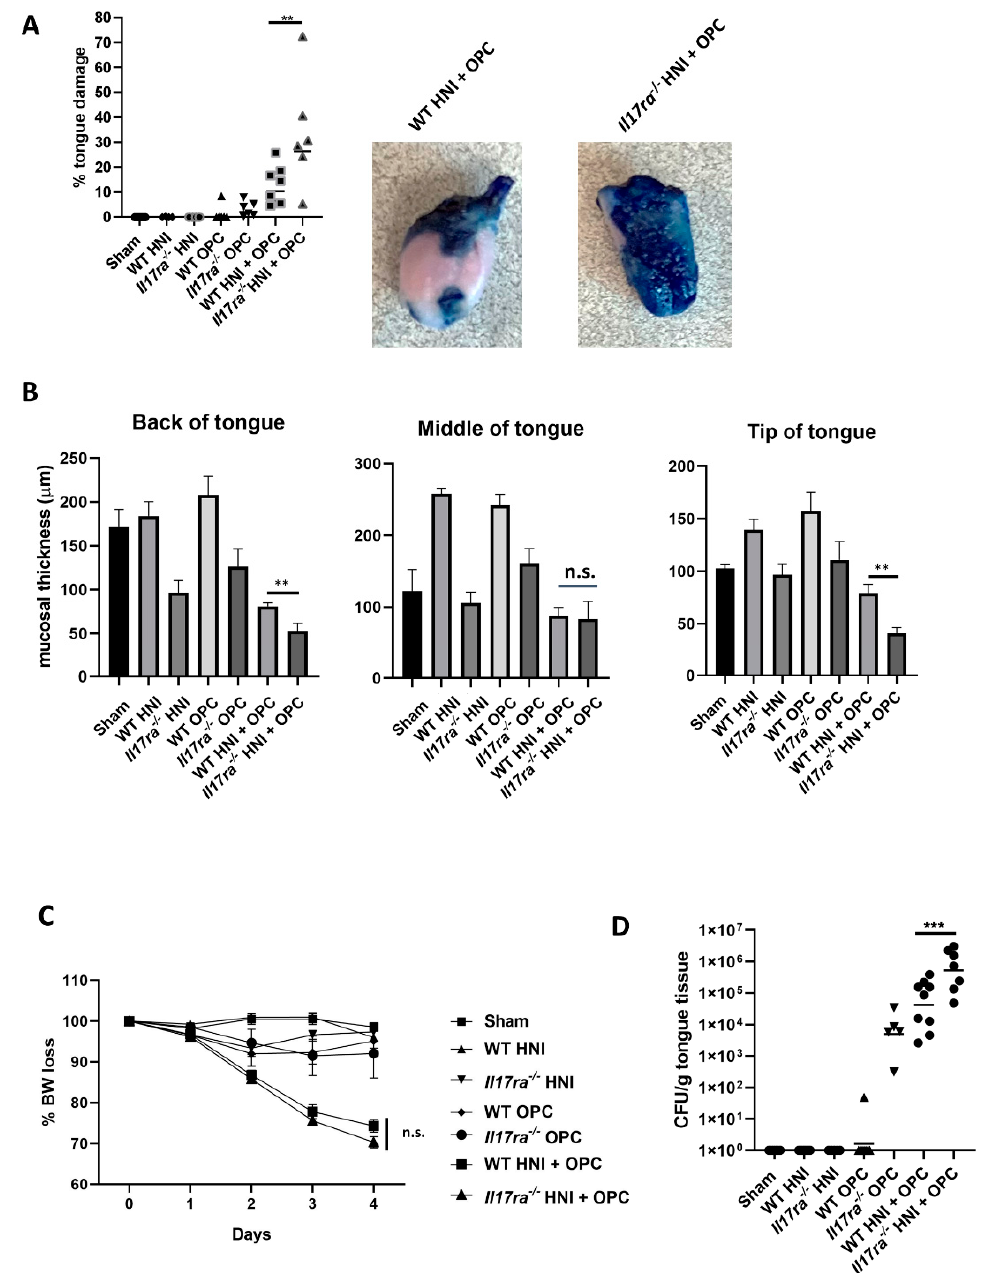
Figure 3. IL-17RA signaling protects against OPC following HNI. ( A ) Quantification of toluidine blue staining by determining the surface area of the tongue positive for blue staining compared to the total surface area of tongue for each mouse (n = 3 or more mice per group) on Day 4 post-infection. Analyzed by one-way ANOVA with Tukey’s post hoc. ( B ) Quantification of mucosal thickness on the tip, middle, and back of tongue. Measured from basal stem cell layer up to papillae using ImageJ software. Three mice were evaluated from each group, and three sections were analyzed per mouse. Investigators determining toluidine blue staining and measurement of mucosal thickness were blinded to treatment and mouse cohort. Analyzed by unpaired Student’s t -test. ( C ) All mice were weighed daily, and % body weight (BW) loss (gram) on each day of infection is indicated. ( D ) WT and Il17ra − / − mice (n = 3–6 mice per group) were subject to HNI and 16 h later infected sublingually with C. albicans and on Day 4 CFU/g of tongue tissue was assessed in triplicate. Analyzed by Mann–Whitney U test. Data shown as geometric means. (** p < 0.01, *** p < 0.001) Data represent 3 experimental